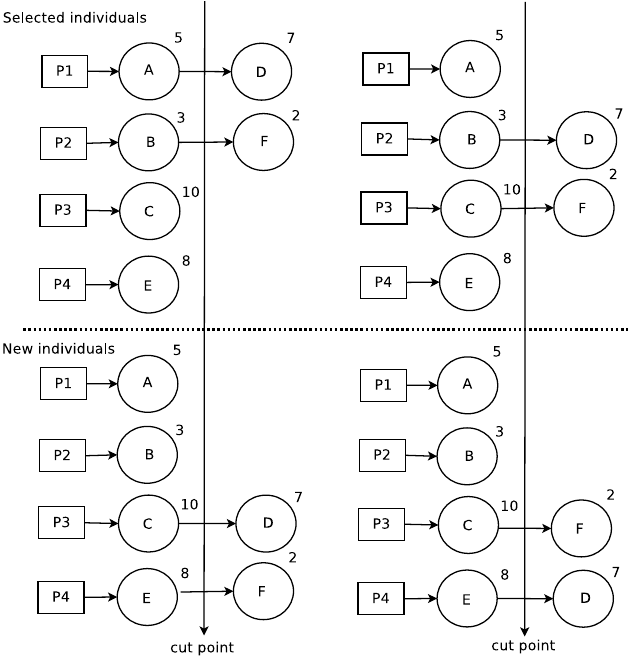
Fig. 2: An example of two individuals generated by two other individuals by crossover